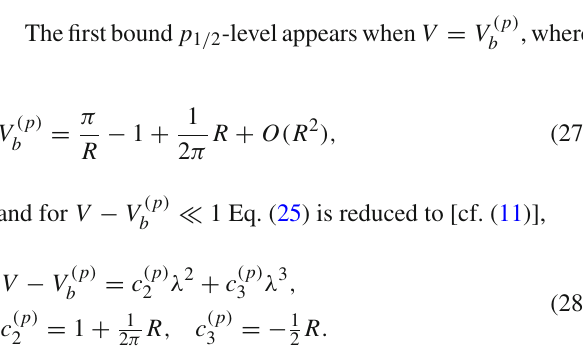
Fig. 6 Scattering phases near the boundary of the upper continuum for (cid:2) = 1 and R = 1 / 20. The shaded areas show the positions and widths of the Breit–Wigner resonances. The numbers indicate the values of (cid:15) (cid:16) ( p ) − V V b